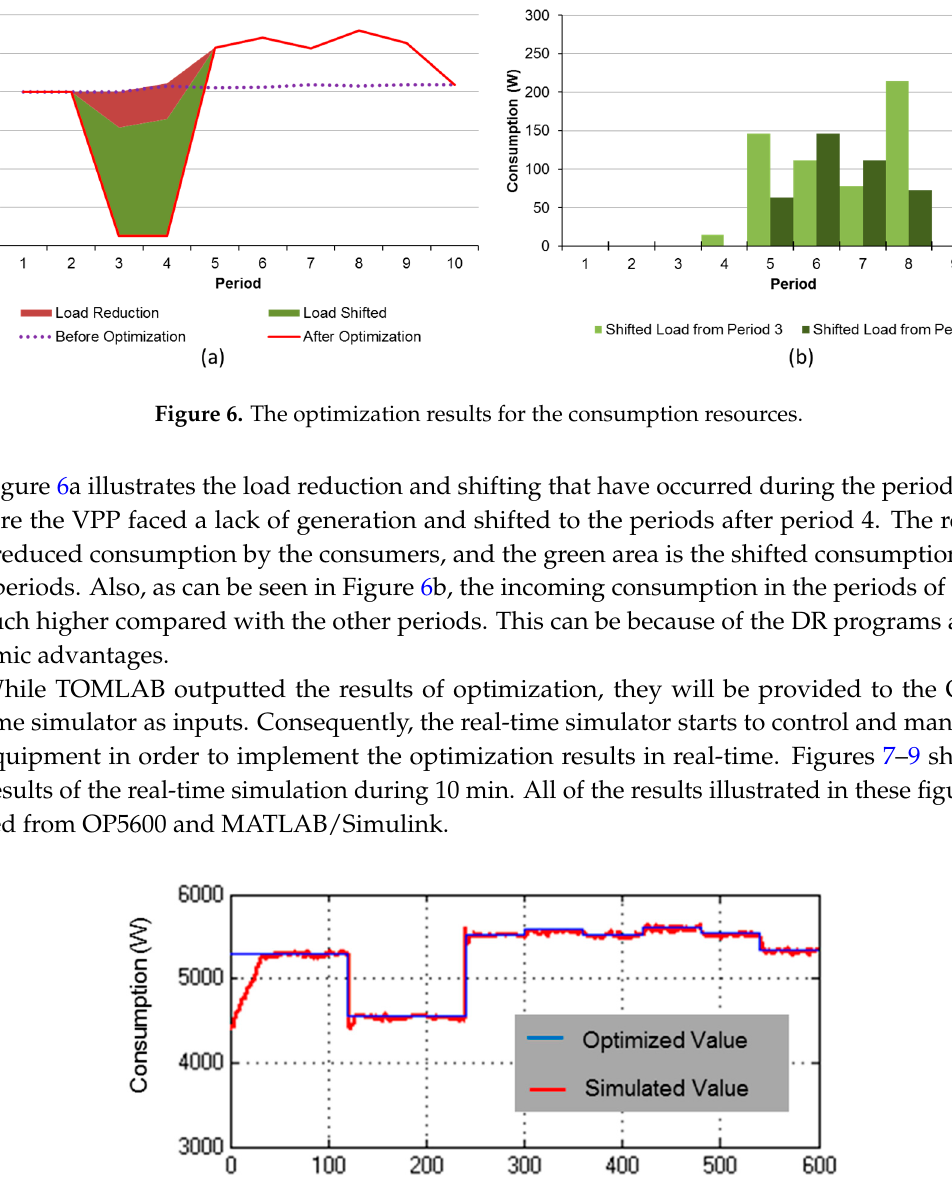
Figure 8. The separated consumption curve of each player of the microgrid Figure 9. Real-time simulation of wind production curve. As Figure 7 illustrates, the total amount of consumption of the microgrid has been reduced and shifted to other periods based on the optimization results, which occurred between the second of 120 to 240 (periods 3 and 4). Also, the denotative consumption profiles of the microgrid have been illustrated in Figure 8. It is obvious that the residential player shifted its consumption; however, the commercial player reduced consumption based on the data received from the OP5600 real-time simulator. Furthermore, Figure 9 represents the wind production simulated by the wind DG player. This generation curve has been simulated based on the real-time wind speed data provided to the emulator from the OP5600 real-time simulator. 5. Conclusions Microgrids are a particular case of distribution networks, namely in the context of smartgrids. Demand response and distributed generation are very relevant resources in the scope of microgrids and smartgrids. As discussed in the present paper, the realistic simulation of the impact of these resources is very important in order to validate the technical and business model’s impact in smartgrids management.